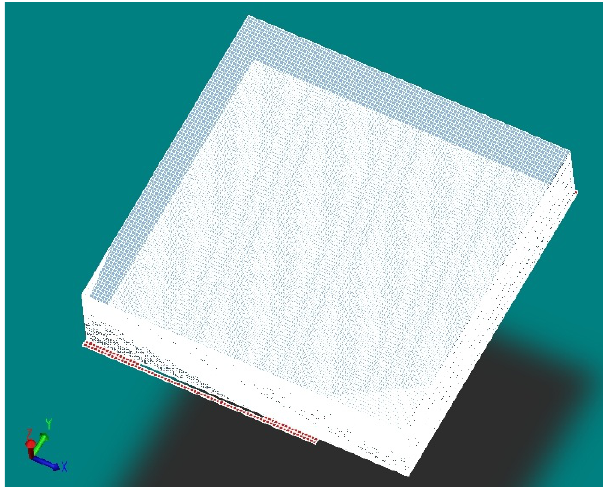
Fig. 8: 3D view of a structural model meshing of 4 electrodes type planar interdigitated array, covered by the full blood medium. The mesh type is Manhattan bricks and the element size is 5 μ m.